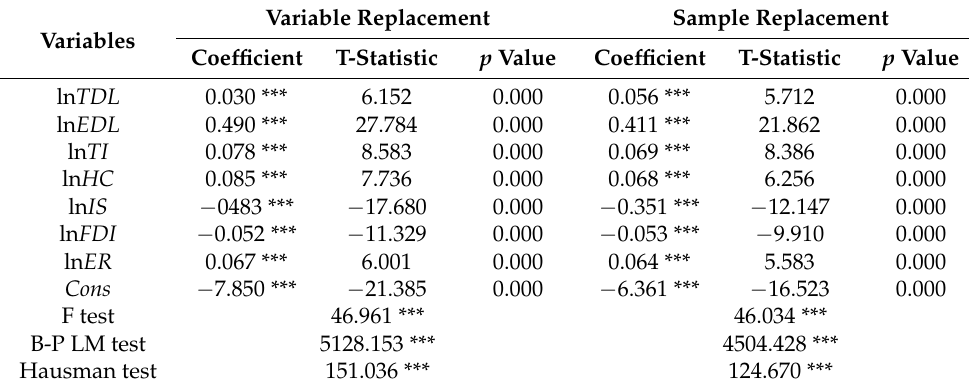
Table 4. Robustness test of the model estimation